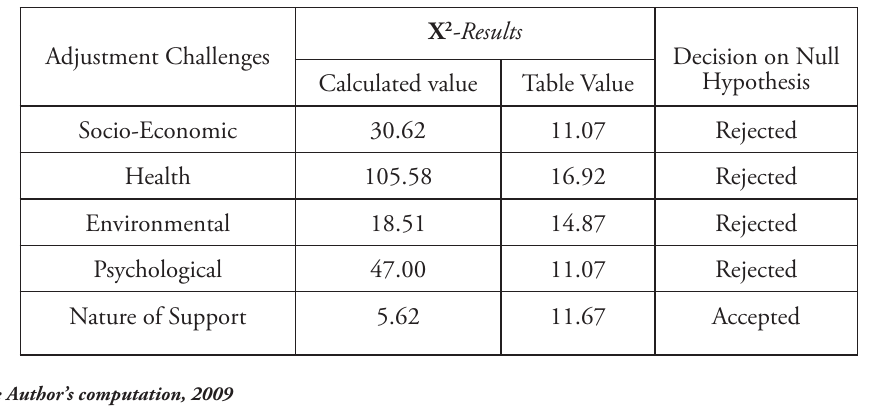
Table 3. X 2 -analyses of the variation in post-disaster challenges in urban and rural areas of Kwara State,